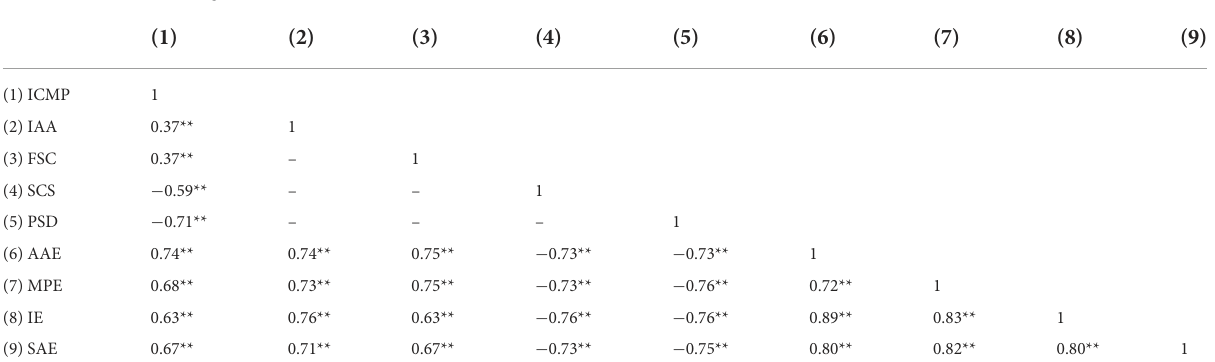
TABLE 2 Correlation analysis of values.